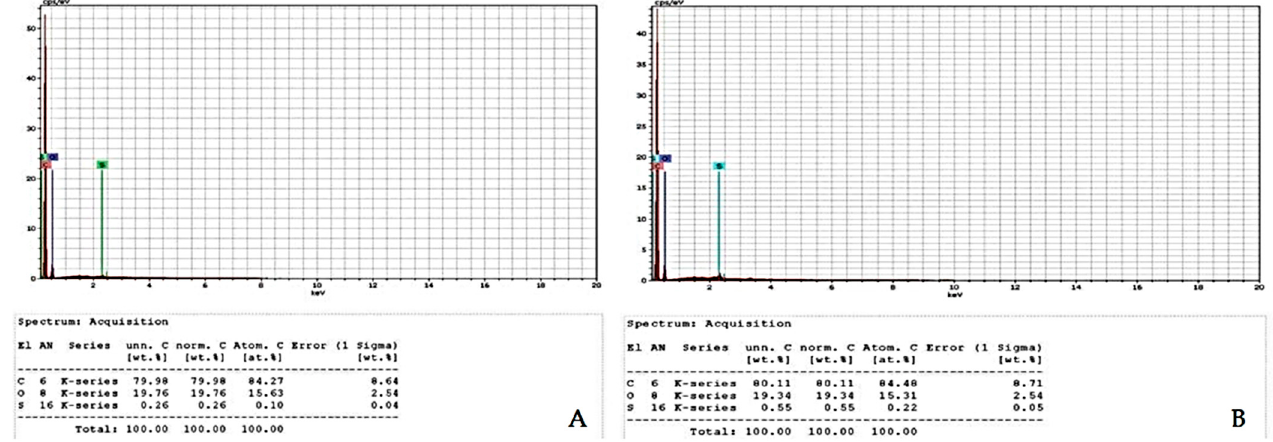
Figure 9. EDS. ( A ) Ecthing 5 s. ( B ) Ecthing 30 s.